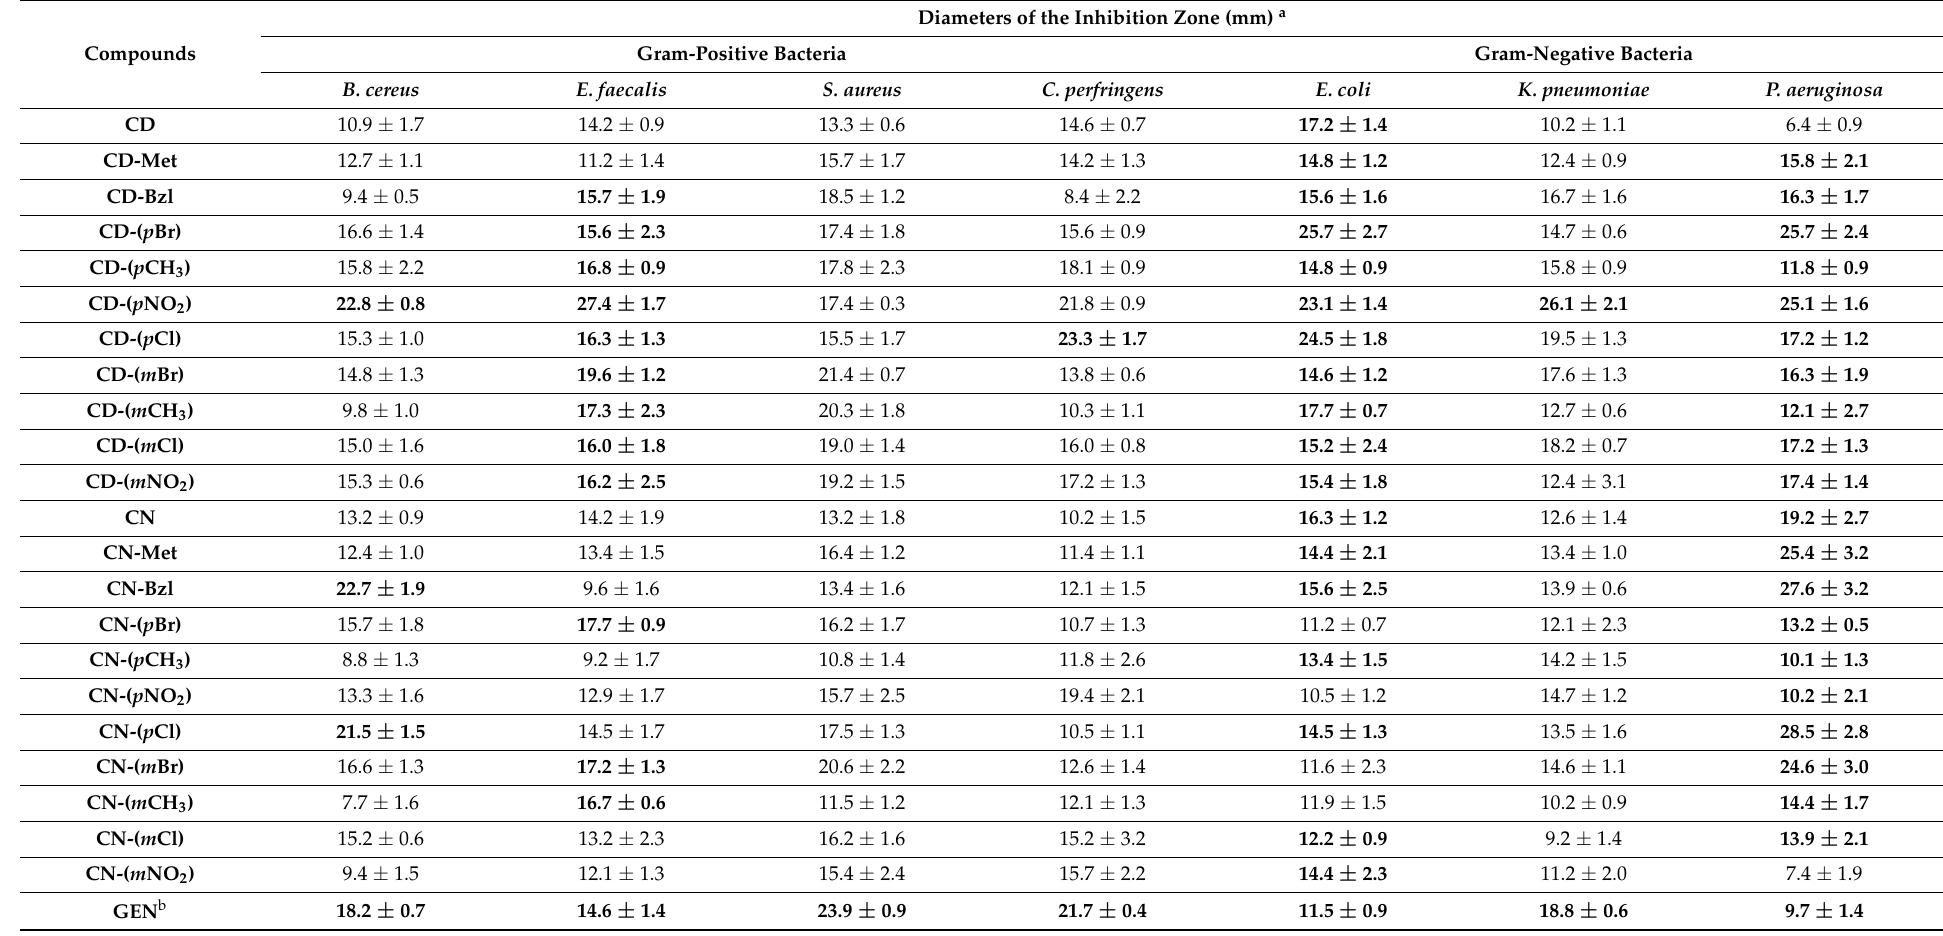
Table 1. Antimicrobial activity of CD and CN derivatives against a panel of Gram-positive and Gram-negative bacterial strains determined by disc diffusion assay. According to the sizes of the inhibitory zone (including the diameter of a disc), the antimicrobial activity is graded as inactive (0–9 mm); mildly active (10–15 mm); moderately active (16–20 mm); and highly active ( ≥ 21 mm). All values are expressed as mean ± SD of three parallel measurements ( n =